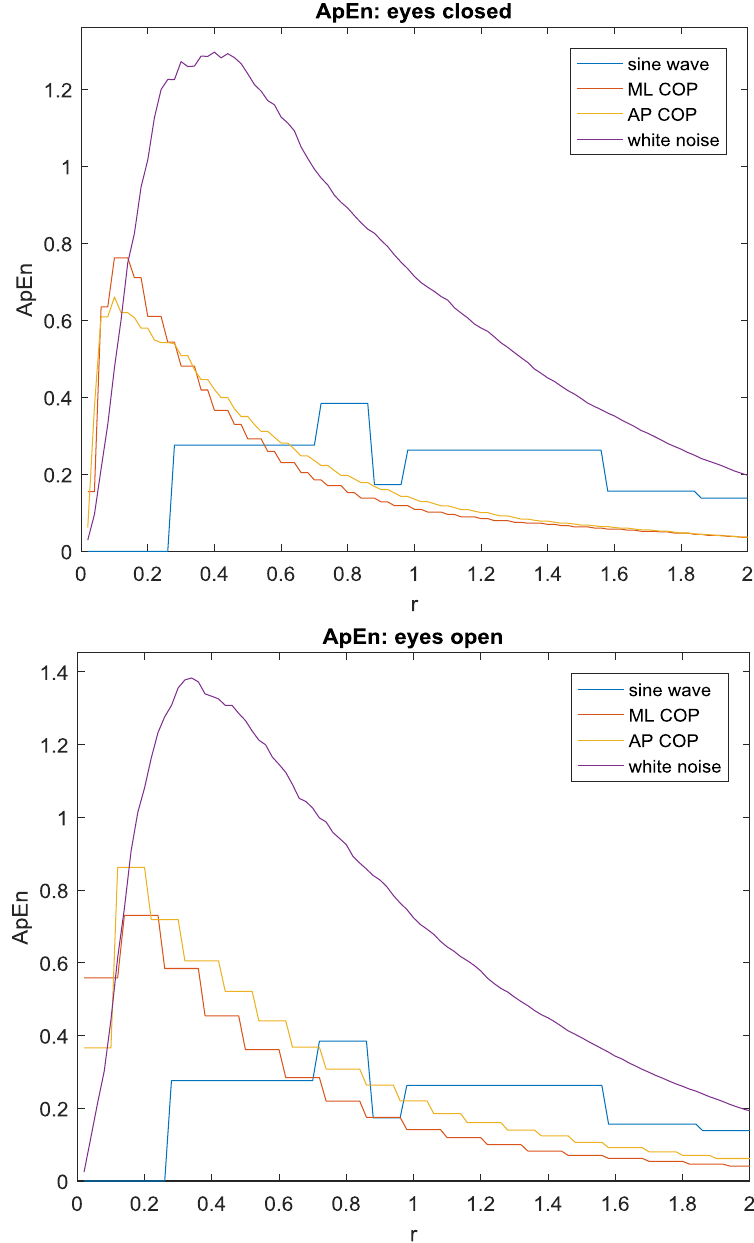
Figure 7. ApEn values of sinusoidal wave, ML COP trajectory, AP COP trajectory and white noise with various unitless thresholds ( r ) are shown for both eyes closed and eyes open conditions.